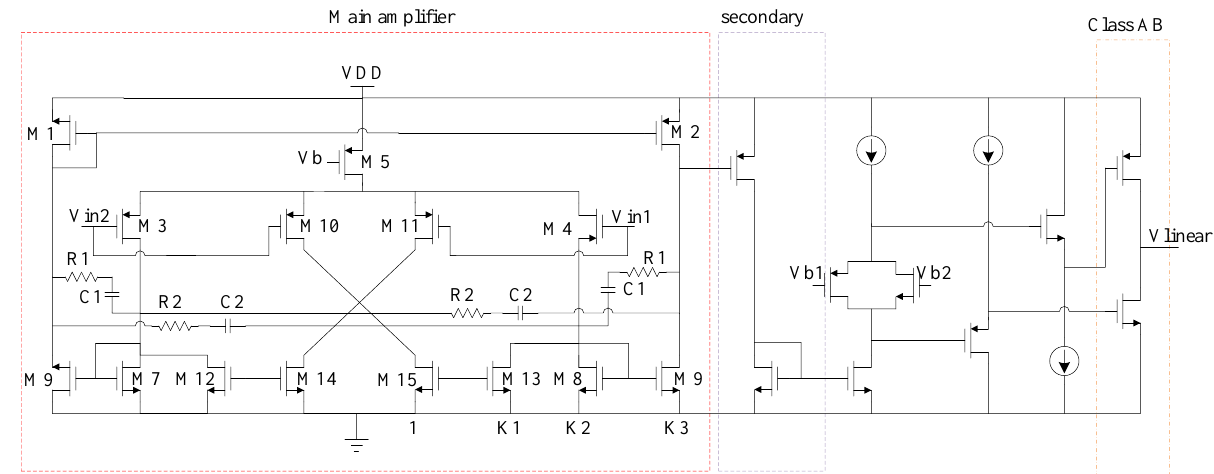
Figure 7. Circuit diagram of the linear amplifier.